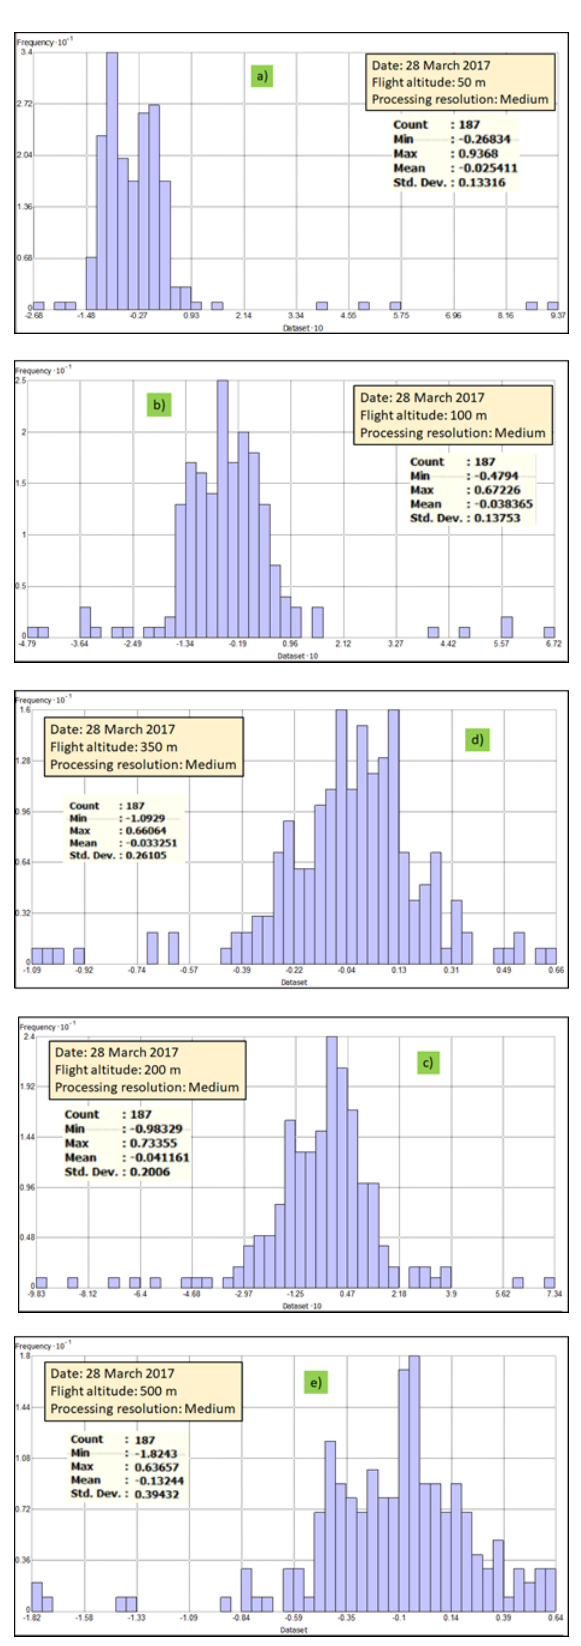
Figure A4: Histogram plot of elevation differences (errors) between measured elevation by total station and the DSM extracted by UAV at diverse altitudes flights